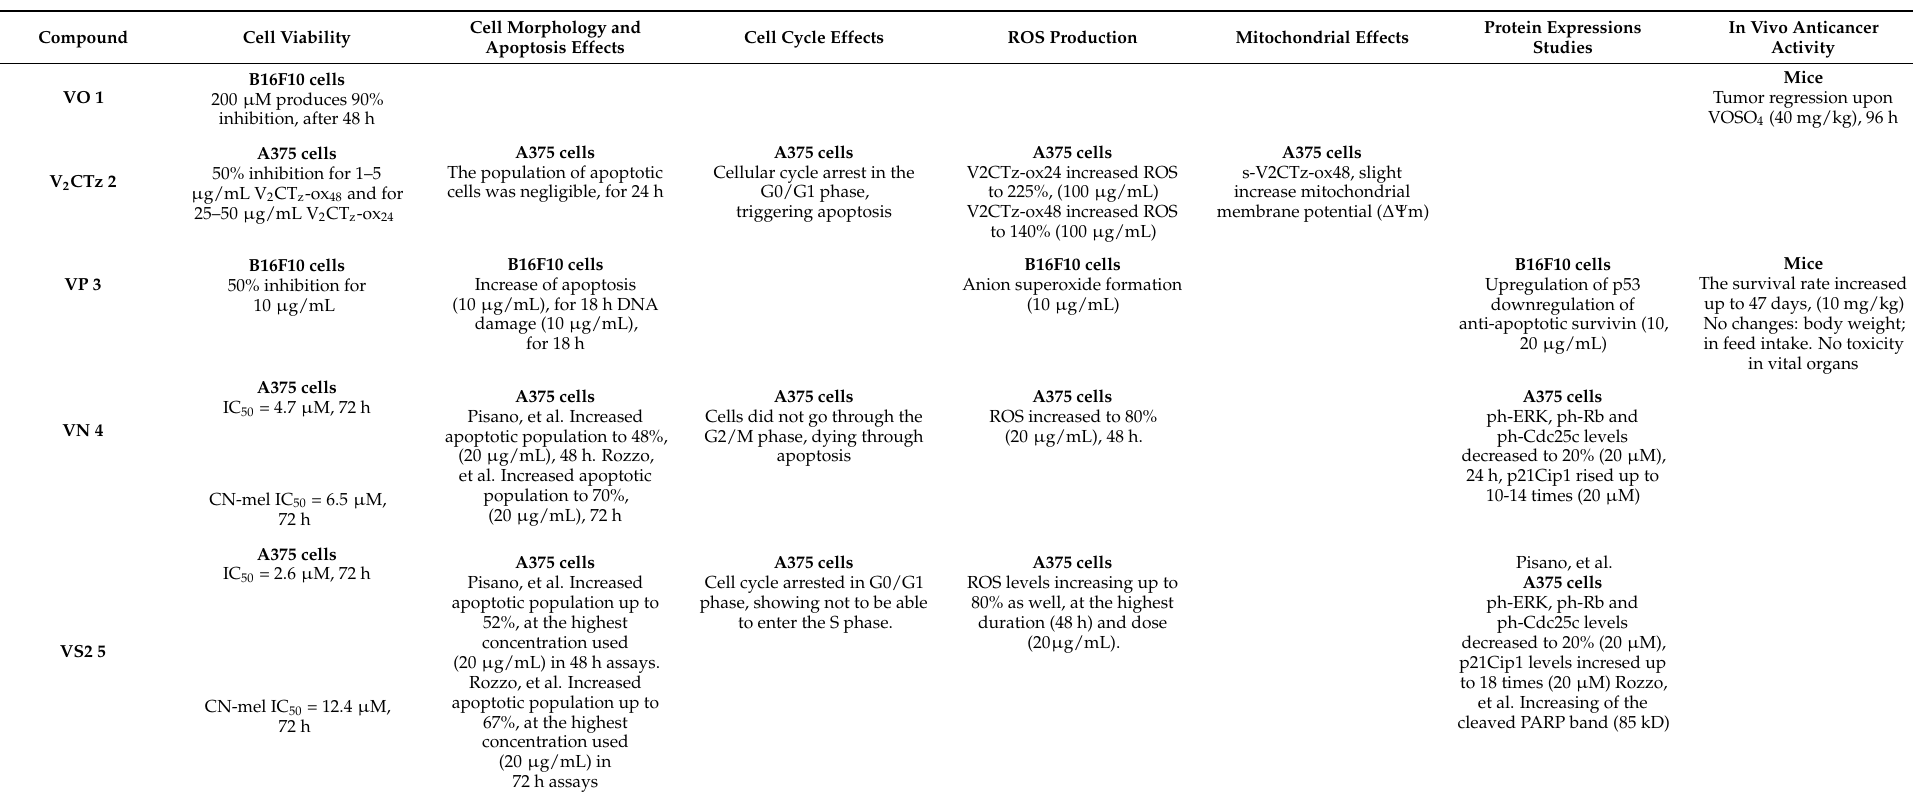
Table 2. Vanadium compounds and materials effects in human melanoma cells lines, namely A375 (human malignant melanoma), CN-mel (human metastatic melanoma), amelanotic melanoma and B16F10 (Mus musculus skin melanoma) namely in: Cell viability, cell morphology and apoptosis effects, cell cycle effects, ROS production, mitochondrial effects and protein expressions. Mice in vivo anticancer studies are also